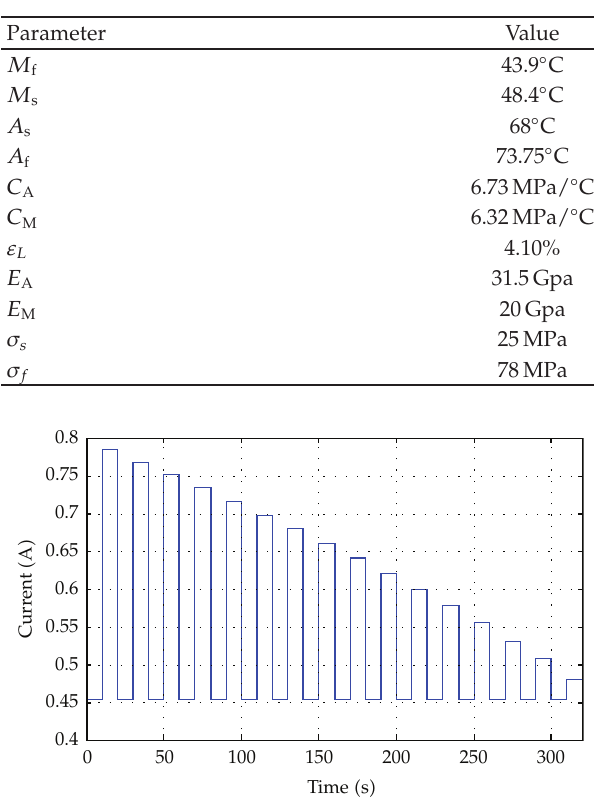
Figure 13: The decaying step current applied in the training